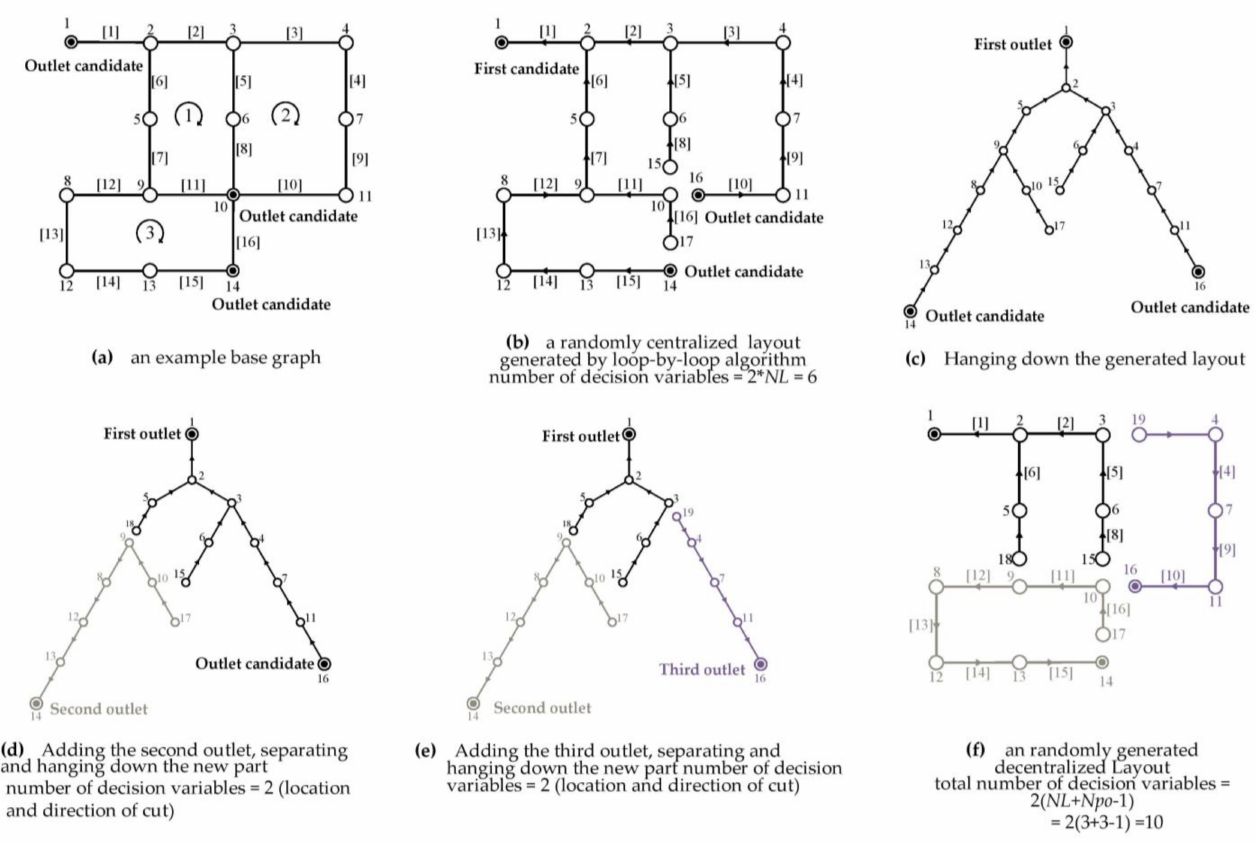
Figure 2. Hanging gardens algorithm